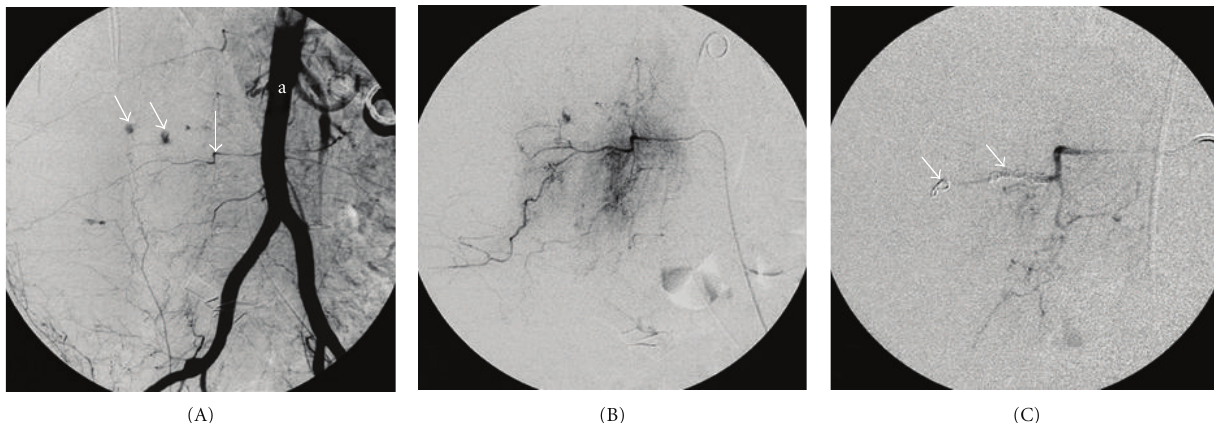
Figure 2: Angiography with coil embolisation; (A) overview of the aorta (a), the bleeding right lumbar artery (arrow) and 2 sites of active bleeding (thin arrows); (B) detailed view of the bleeding lumbar artery with contrast extravasation; (C) coil embolisation (arrows) of the bleeding right lumbar